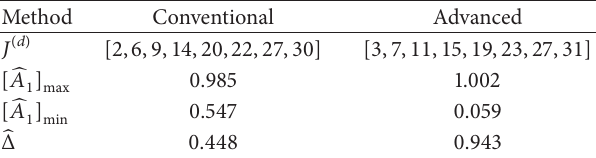
Table 2: Optimal switching index systems and modulation ranges for conventional and advanced designs with 𝑀 = 8 switching